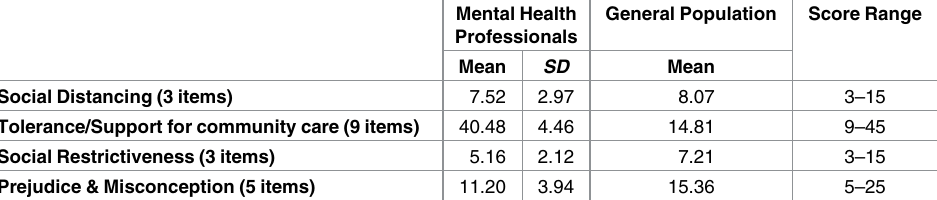
Table 2. AMI-SG factor scores among mental health professionals and general population in Singapore.